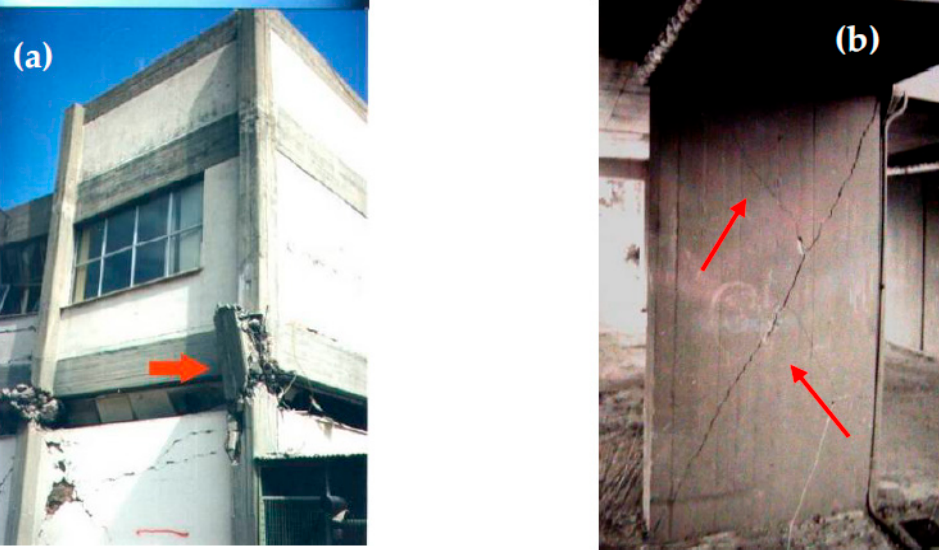
Figure 3. ( a ) Shear failure of an RC short column at the ground floor of a two-story RC building. Aigio, Greece 1995 earthquake sequence. ( b ) Detail of shear damage of a shear wall at the ground floor of a four-story RC building. Pyrgos, Greece 1993 earthquake sequence [1].